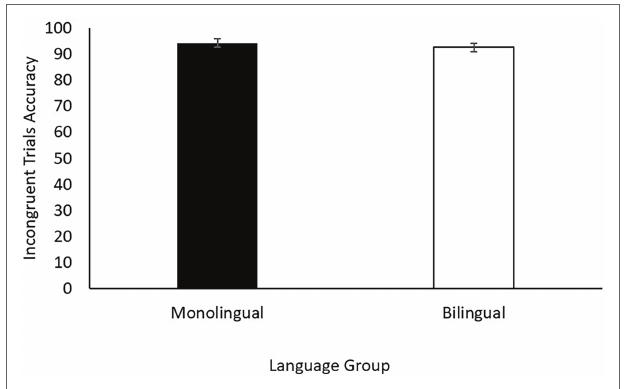
FIGURE 1 | Mean and SE for reaction time (RT) in milliseconds (incongruent- congruent trials) in the flanker task (inhibitory